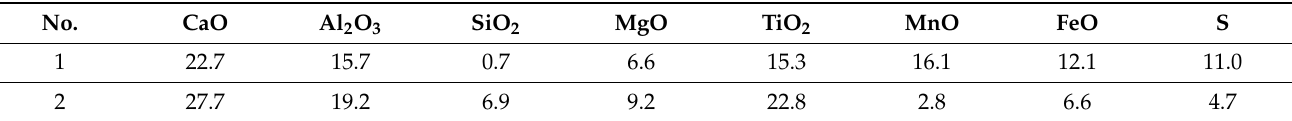
Table 4. The chemical composition of typical Ti-oxide-containing inclusions in the final products.